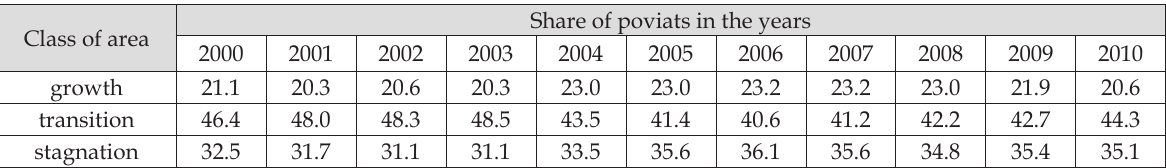
Table 4. Structure of classes of growth and stagnation areas by NUTS 4 units in the years